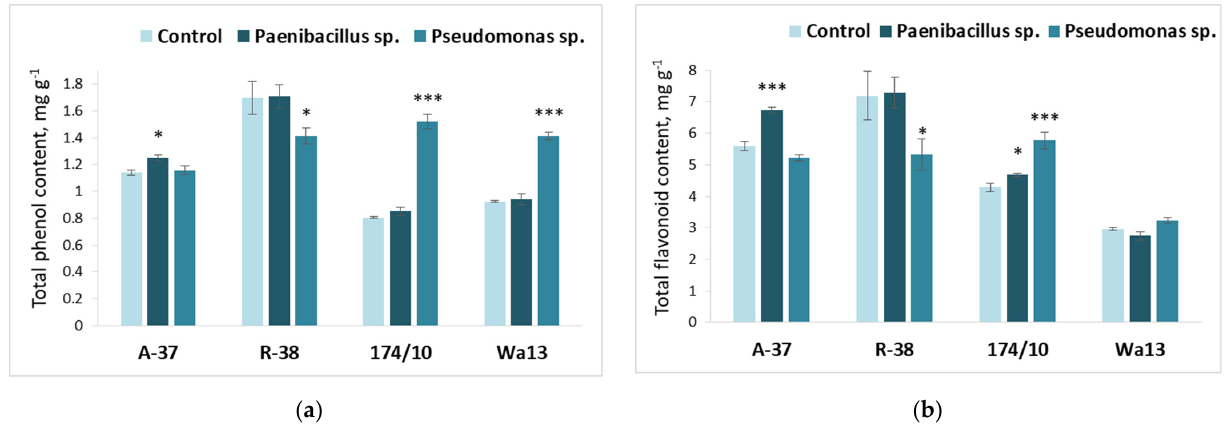
Figure 6. Average total phenol ( a ) and flavonoid ( b ) content in the leaves of different Populus genotypes (A-37 and R-38, P. tremula ; 174/10 and Wa13, P. tremula × P. tremuloides ), inoculated with Paenibacillus sp. and Pseudomonas sp. bacteria. Statistically significant differences from the bacterium-free control variant are indicated (for each genotype separately): * p < 0.05; *** p < 0.001.